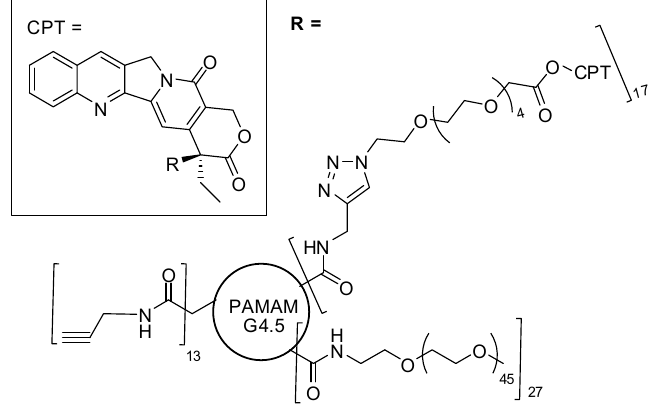
Figure 22. Dendrimer prodrug synthesized using click chemistry [86].